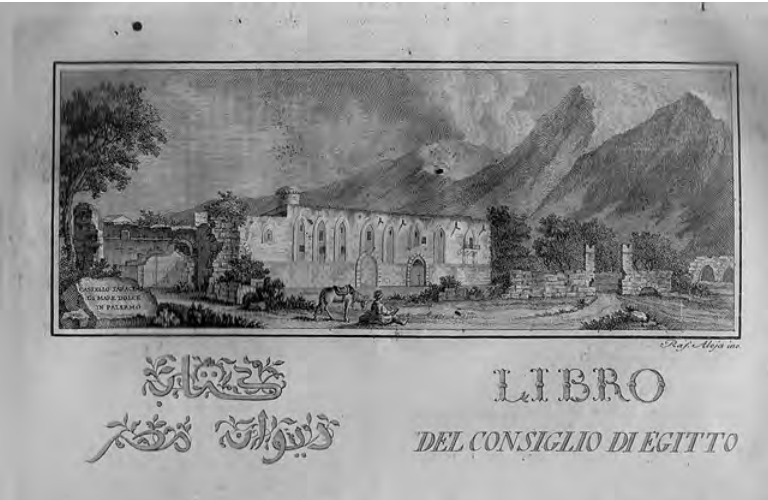
Figure 6. Drawn by Dufourny from original by RaffaelloAjola Castello Saraceno di Maredolce in Palermo. Gabinetto Disegni e Stampe,Palazzo Abatellis Regional Gallery, Palermo, n.